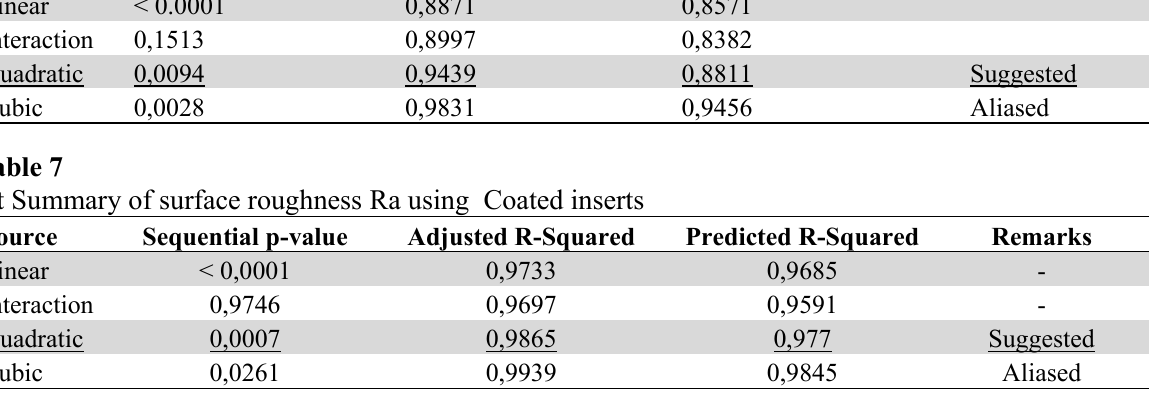
Fit Summary of surface roughness Ra using Uncoated inserts Source